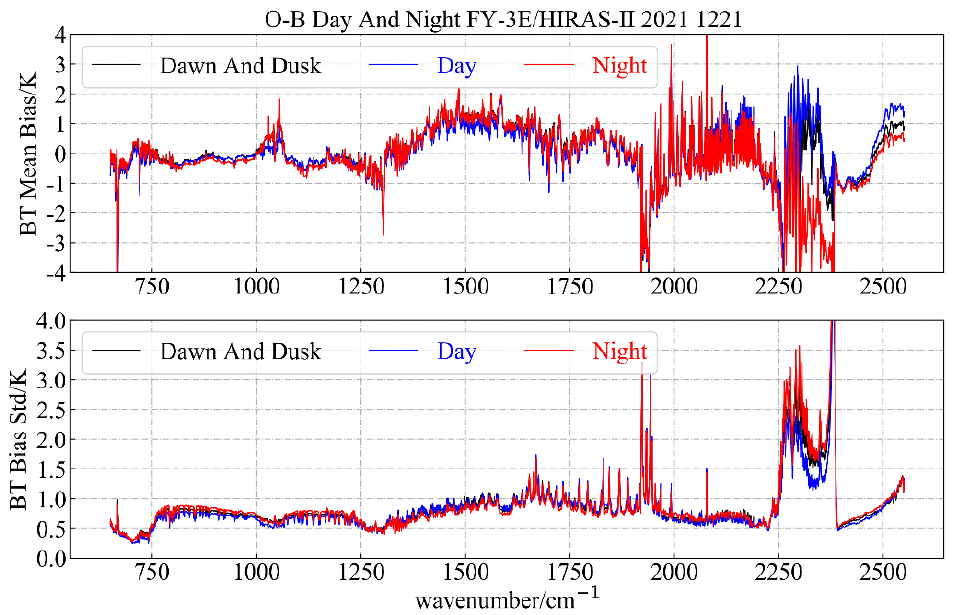
Figure 20. The bias of OMB distribution during day and night.